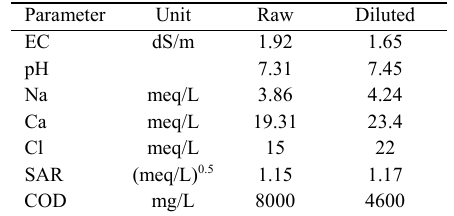
Table 2: Chemical characteristics of raw and diluted wastewater